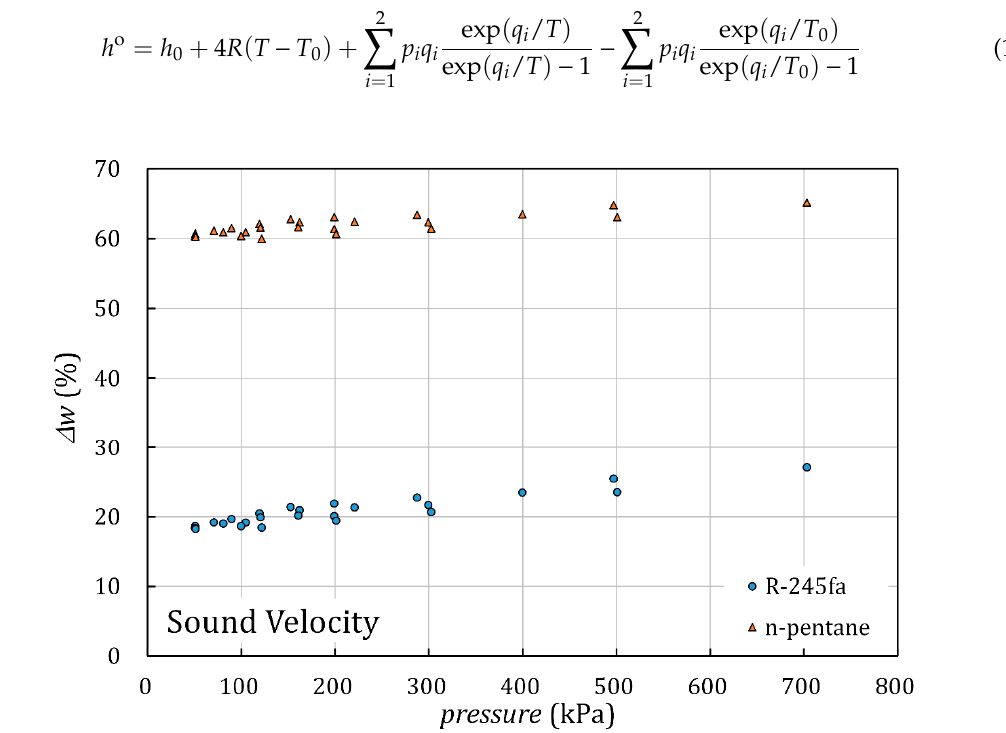
Figure 8. Comparison of the sound velocity of HFE-356mmz with that of R-245fa and n-pentane. The base line corresponds to the sound velocity of HFE-356mmz.